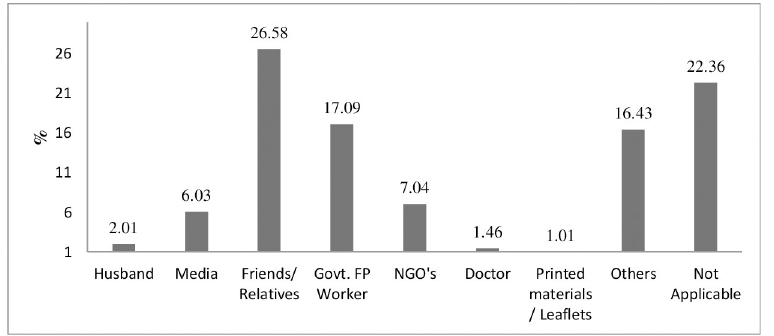
Fig 1. Sources of information regarding family planning methods during COVID-19 pandemic.